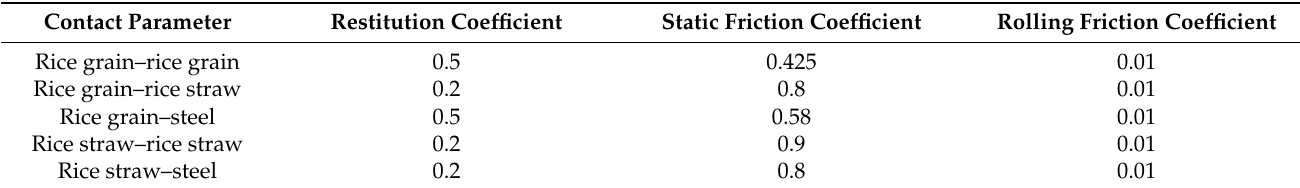
Table 4. Contact parameters between various materials [6].